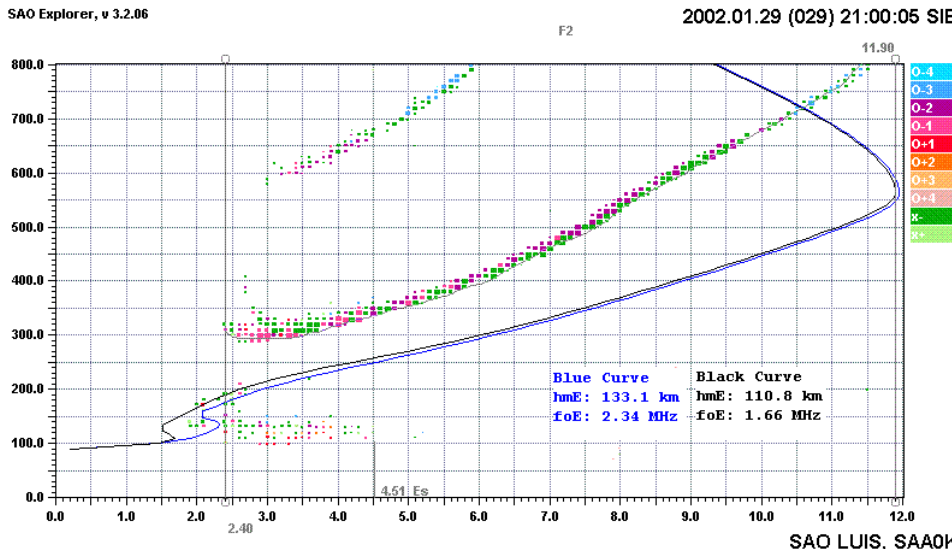
Fig. 4. Ionogram from 29 January 2002 obtained at 18:00 LT (21:00 UT) at S˜ao Lu´ıs, Brazil, superimposed by its corresponding electron density profile. The black curve was obtained by the SAO-Explorer Automatic Ionogram Scaling Program while the blue curve was obtained after reprocessing the ionogram.